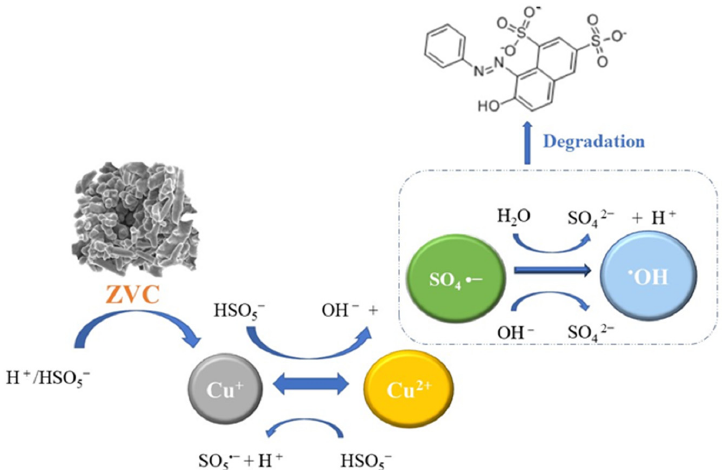
Figure 4. Possible reaction mechanism of ZVC/PMS system for OG degradation.